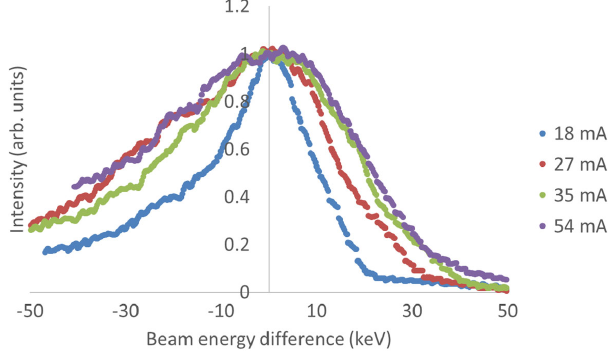
FIG. 22. Energy distribution of the beam energy spectra main peak at four beam currents.